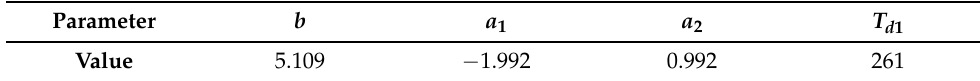
Table 1. The parameters of the transfer function SYS1.